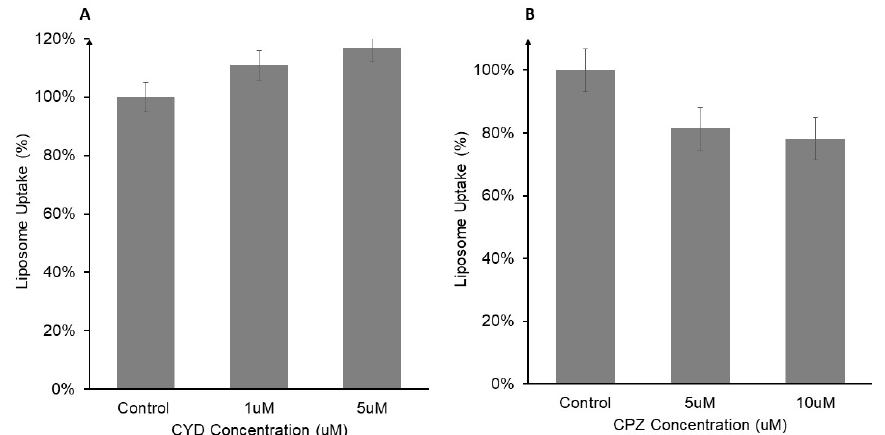
Figure 5. Effect of endocytic pathway inhibitors in the uptake of SCB liposomes as measured by flow cytometry. Cytochalasin D (CYD), a macropinocytosis inhibitor, and chlorpromazine (CPZ), a clathrin-mediated endocytosis inhibitor, were cultured with neuroblastoma cells for 30 min. Then, 0.2 mM of SCB liposomes were added and co-cultured for an additional 2 h, and finally the fluorescence of the liposomes was detected by flow cytometry. Bars indicate the mean and standard error. ( A ) Effect of CYD on SCB liposome uptake ( n = 6); ( B ) effect of CPZ on SCB liposome uptake ( n = 3).